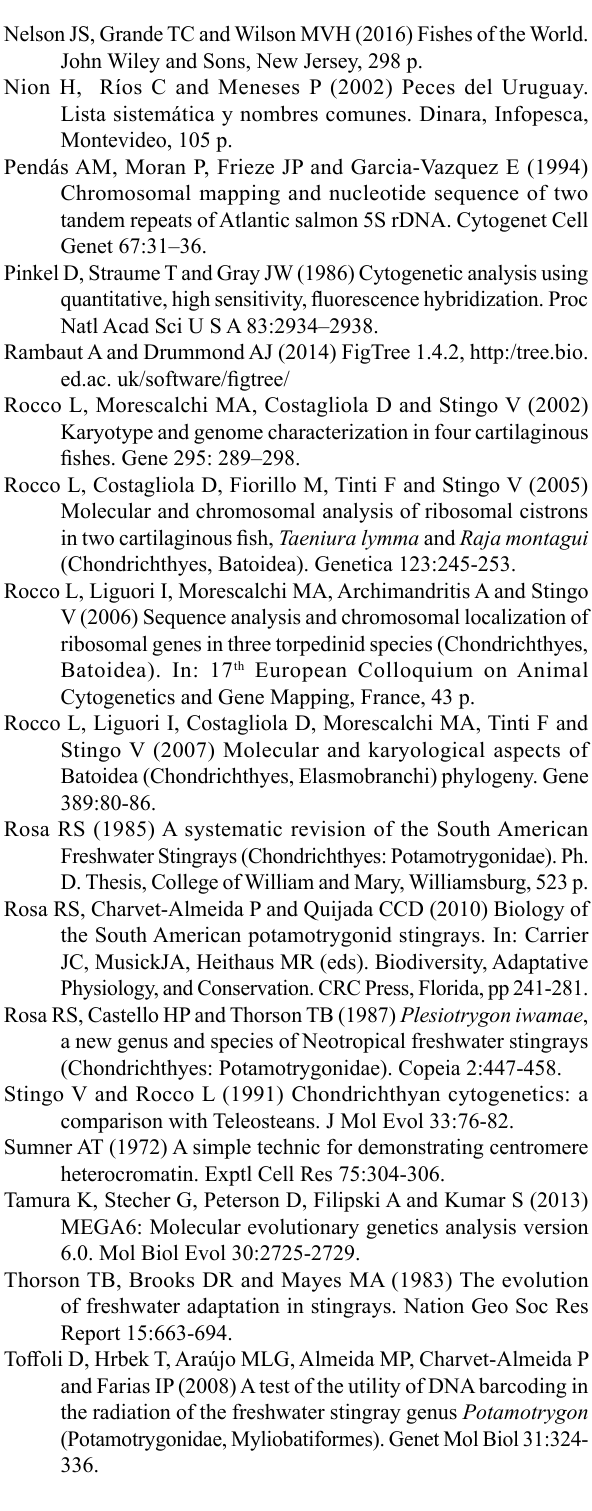
Figure S1 – South America/Brazil showing the sampling location of the potamotrygonins species (black star) in the Amazon